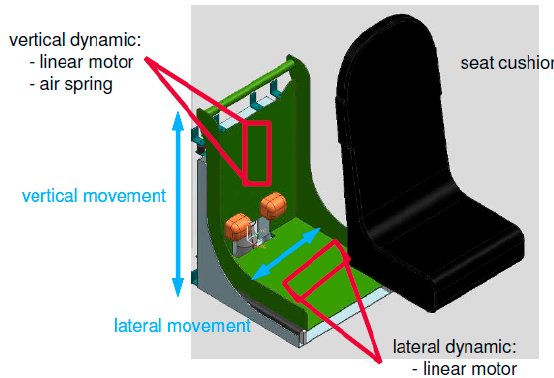
Figure 9. CAD model of active seating suspension system [50].